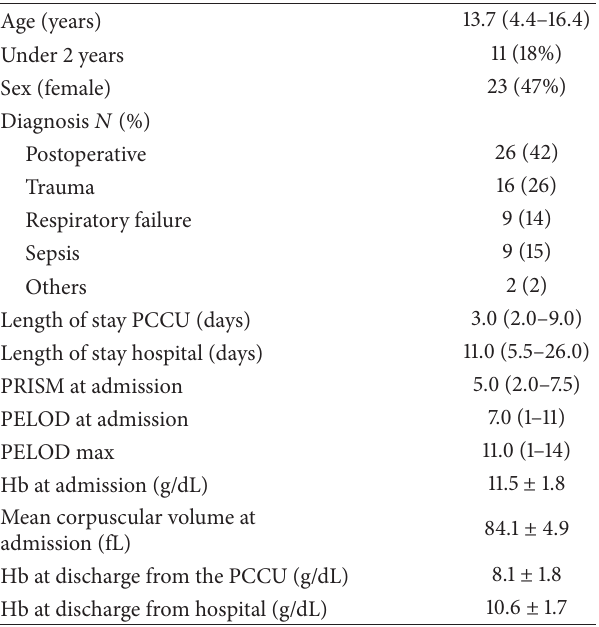
Table 3: Follow-up patient characteristics ( 𝑛 = 62